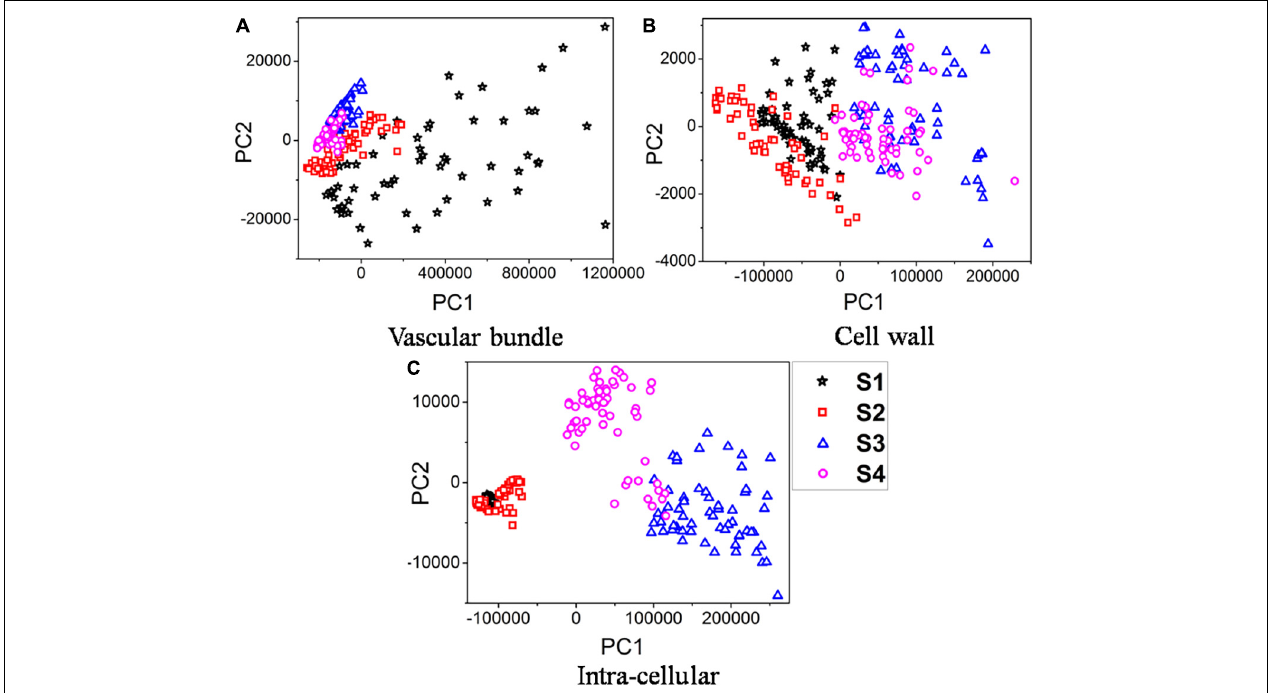
FIGURE 4 | PCA plots of samples infected over time. (A) Vascular bundle. (B) Cell wall. (C)